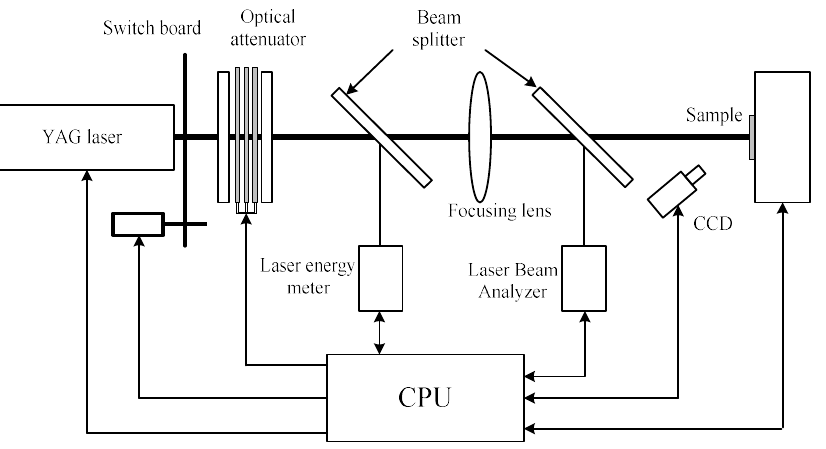
Figure 2. Schematic diagram of the apparatus used for in situ image laser damage testing system.